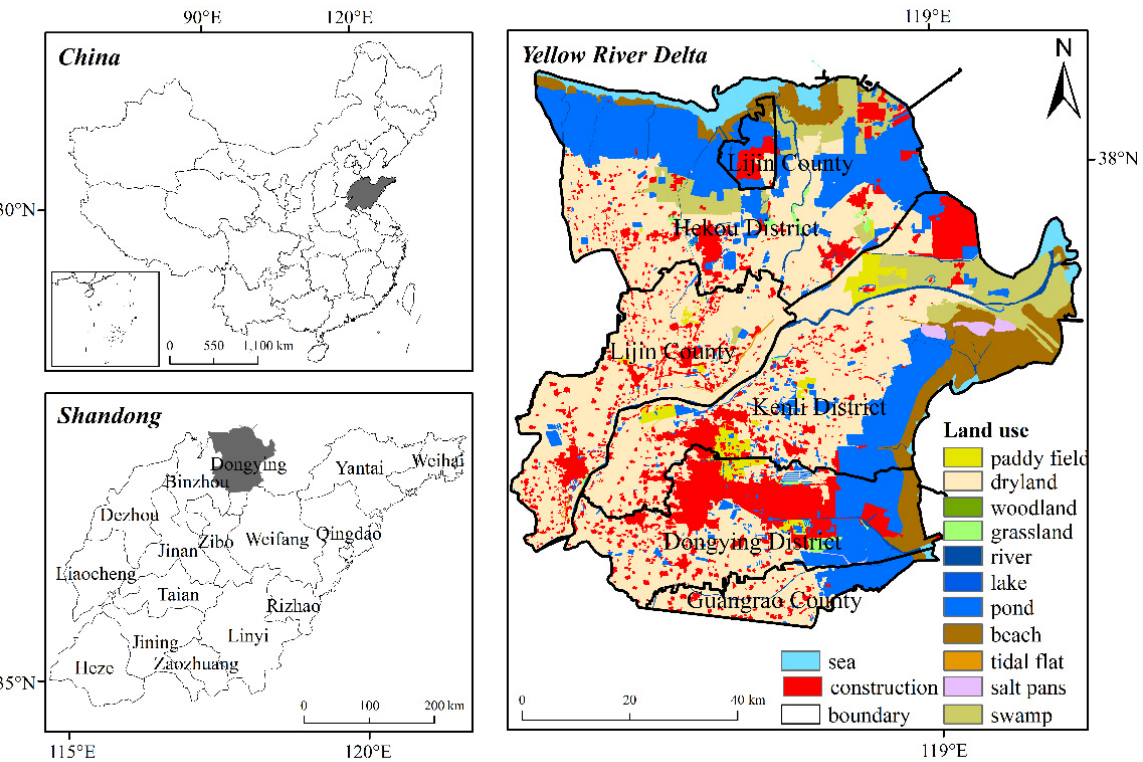
Figure 1. Location of the study area.